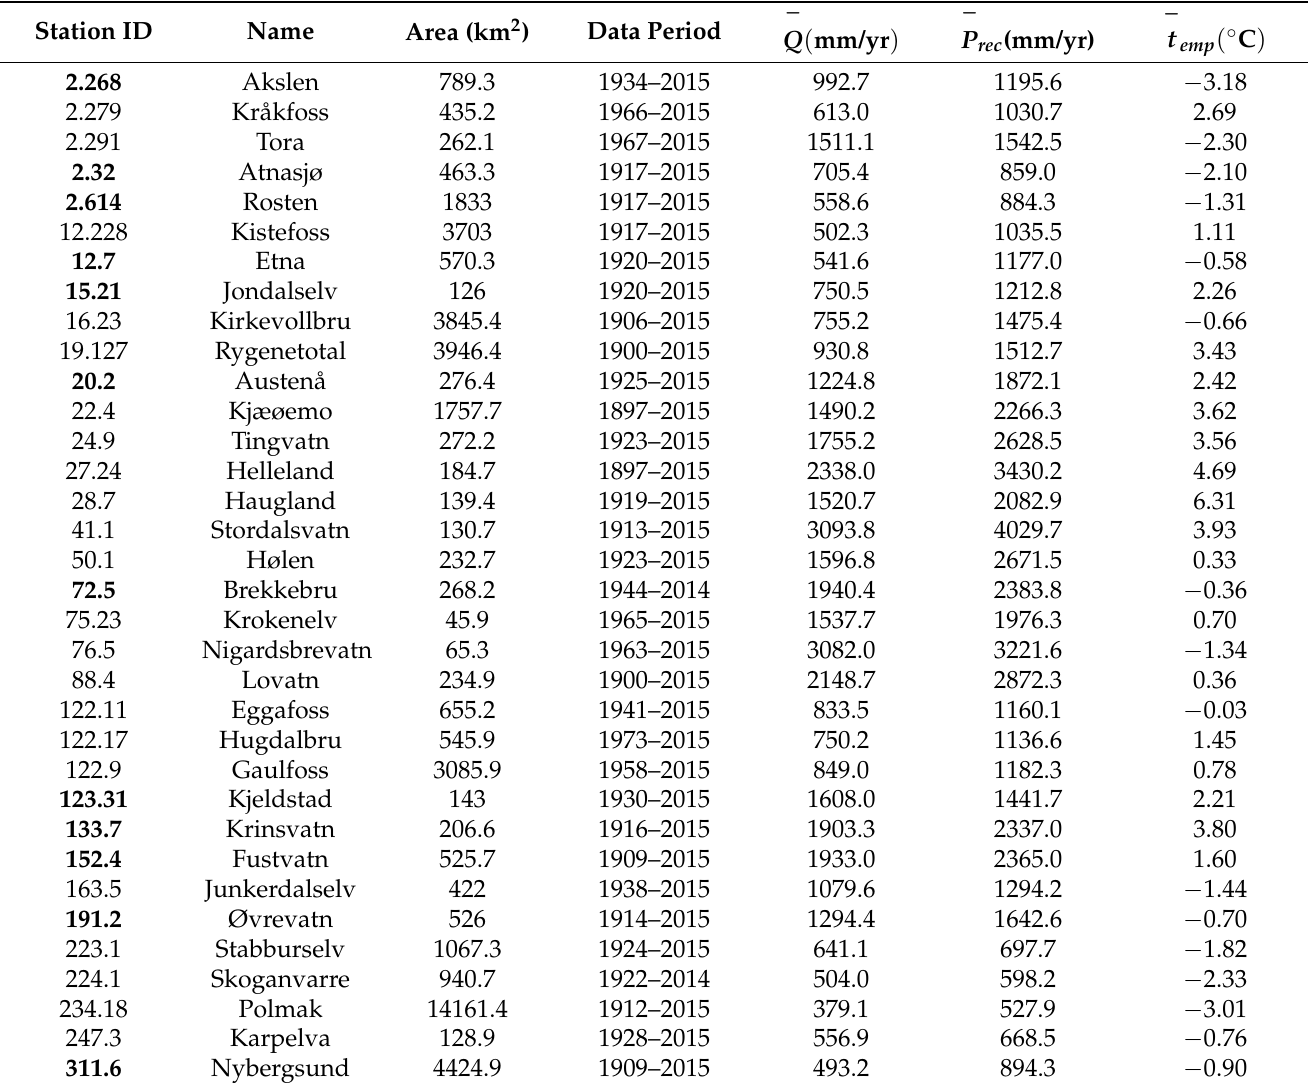
Table 1. The information of 34 hydrological stations in Norway. The stations with bold fonts were selected for further